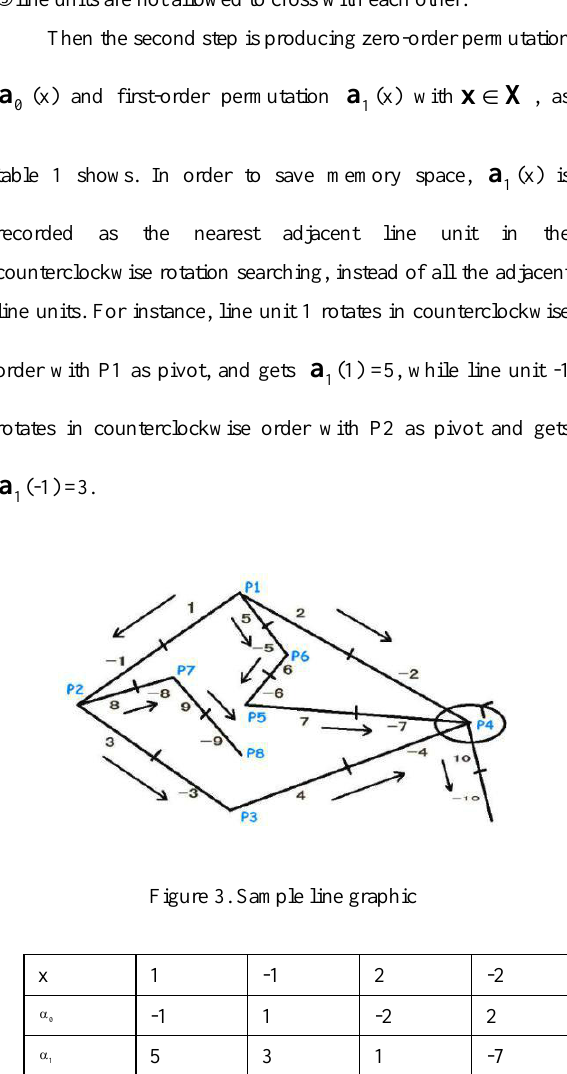
Table 1. Part of line unit algebraic structure of Figure